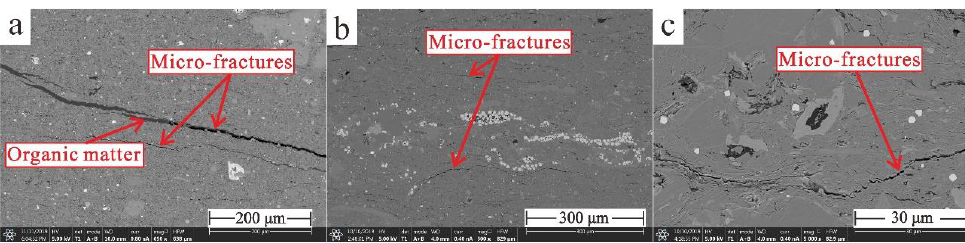
Figure 5. FE-SEM images of micro-fractures. ( a ) SK1S36, mudstone; ( b ) and ( c ) SK1S16, mudstone.